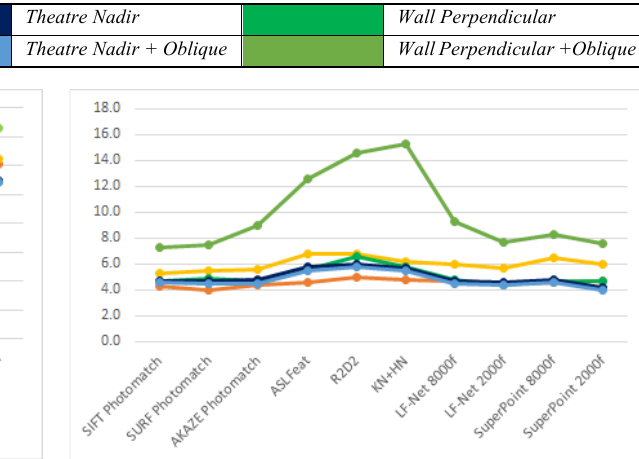
Figure 4: Average MTL for extracted tie points. ASLFeat, R2D2 and Key.Net+HardNet always show a higher MTL value with respect to the other learning-based methods.